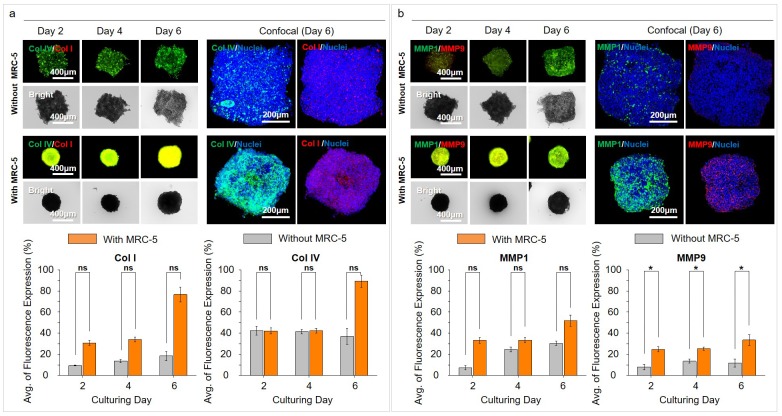
Expression of ECM related markers in MCTs.(a) Expression of collagen types I and IV without and with the MRC–5 groups in the CLF concave microwell array. (b) Expression of MMP1 and MMP9 without and with the MRC–5 groups on the CLF concave microwell array. p > 0.05(ns), p < 0.05(*).